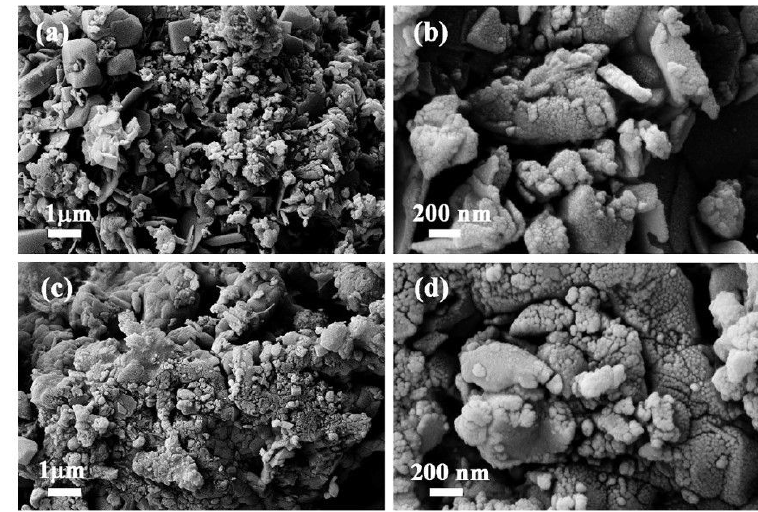
Figure 3. FESEM images of (a, b) Fe-Co-V/Zeolite and (c, d) Fe-Co-Mo/Zeolite CNs.